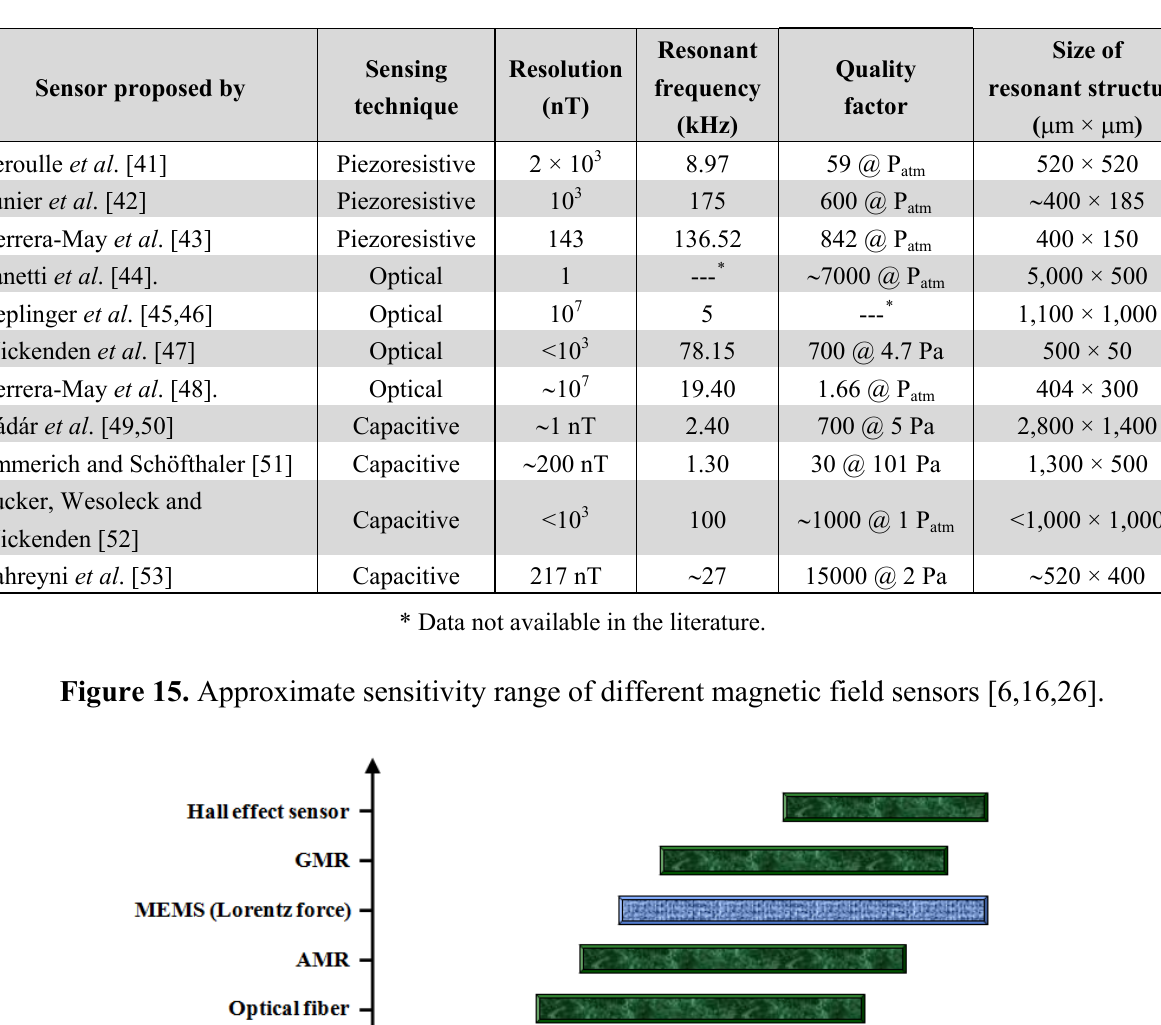
Table 1. Main characteristics of resonant magnetic field sensors based on MEMS technology.